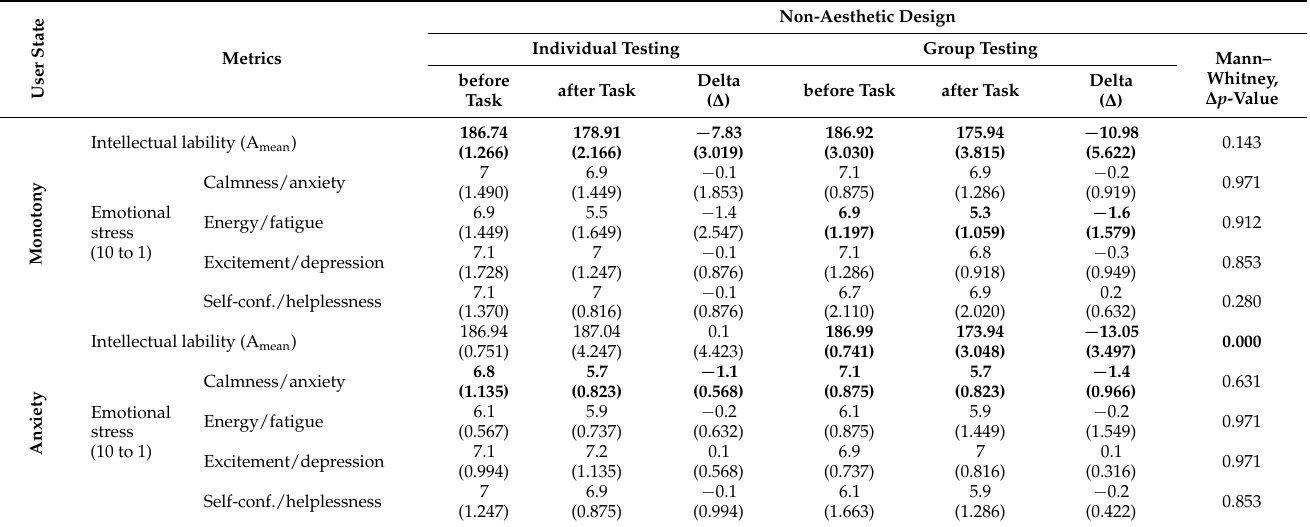
Table 6. The results of the experiment, non-aesthetic design, individual vs. group